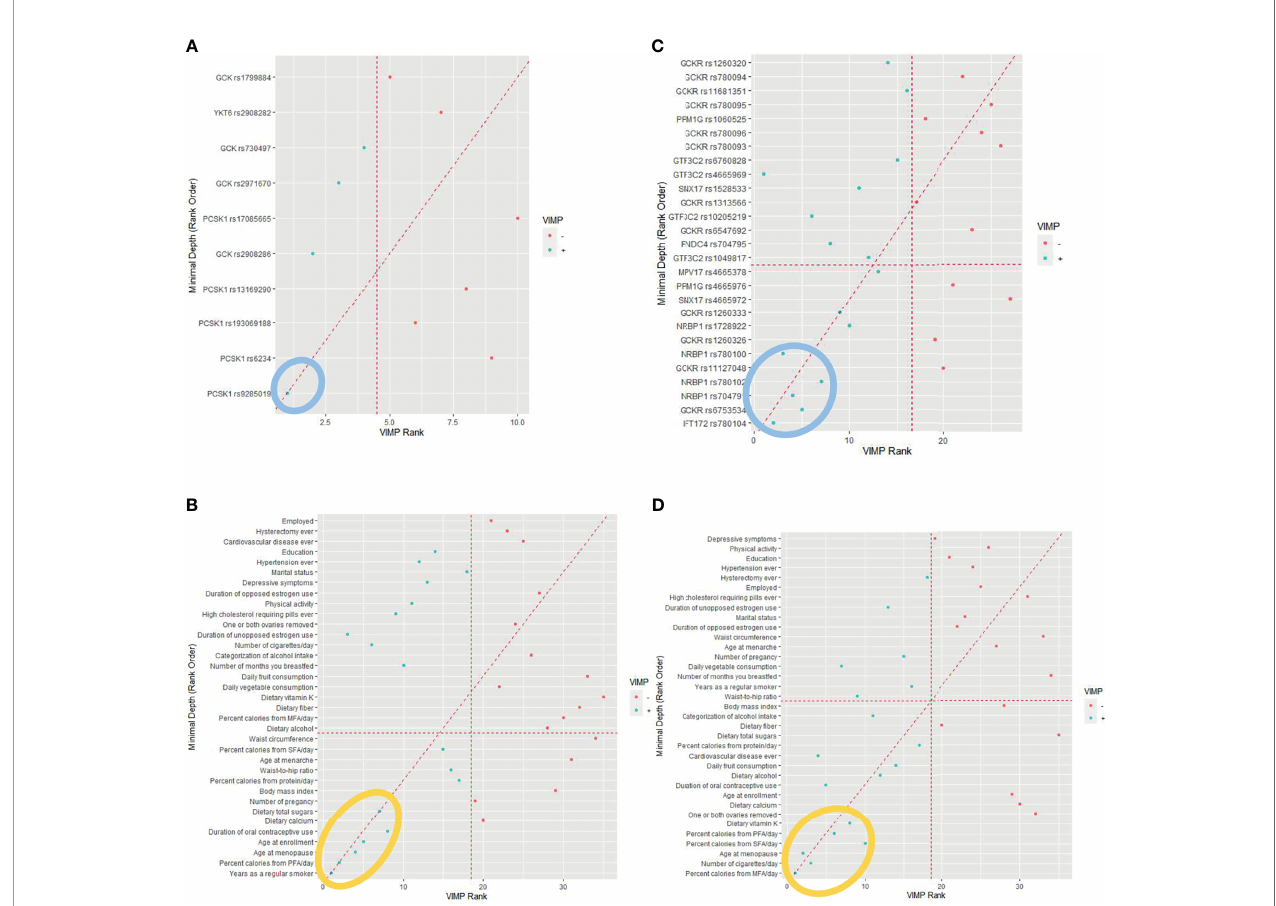
FIGURE 1 | Random survival forest comparing rankings between minimal depth and variable of importance (VIMP). (A) African American women. (Note: The 1 genetic marker within the blue oval was identi fi ed as the topmost in fl uential predictor. (B) African American women. (MFA, monounsaturated fatty acid; PFA, polyunsaturated fatty acid; SFA, saturated fatty acid. Note: The 6 lifestyle variables within the orange oval were identi fi ed as the topmost in fl uential predictors. (C) Hispanic American women. (Note: The 5 genetic markers within the blue oval were identi fi ed as the topmost in fl uential predictors. (D) Hispanic American women. (MFA, monounsaturated fatty acid; PFA, polyunsaturated fatty acid; SFA, saturated fatty acid. Note: The 6 lifestyle variables within the orange oval were identi fi ed as the topmost in fl uential